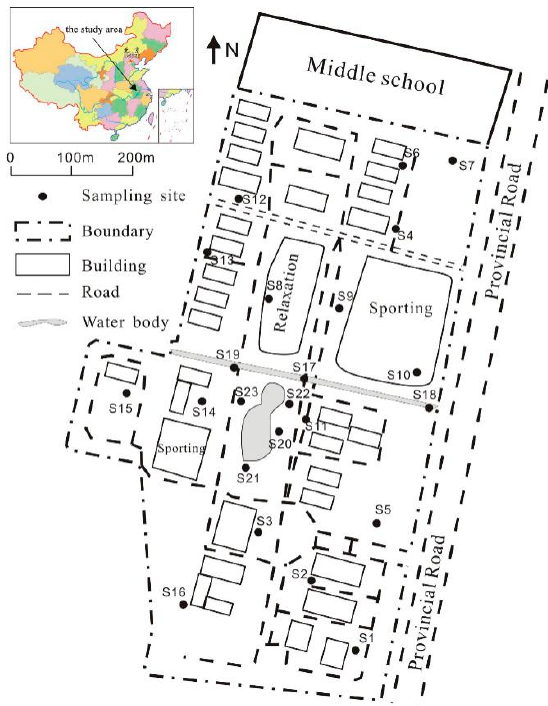
Figure 1. Study area and sampling sites.